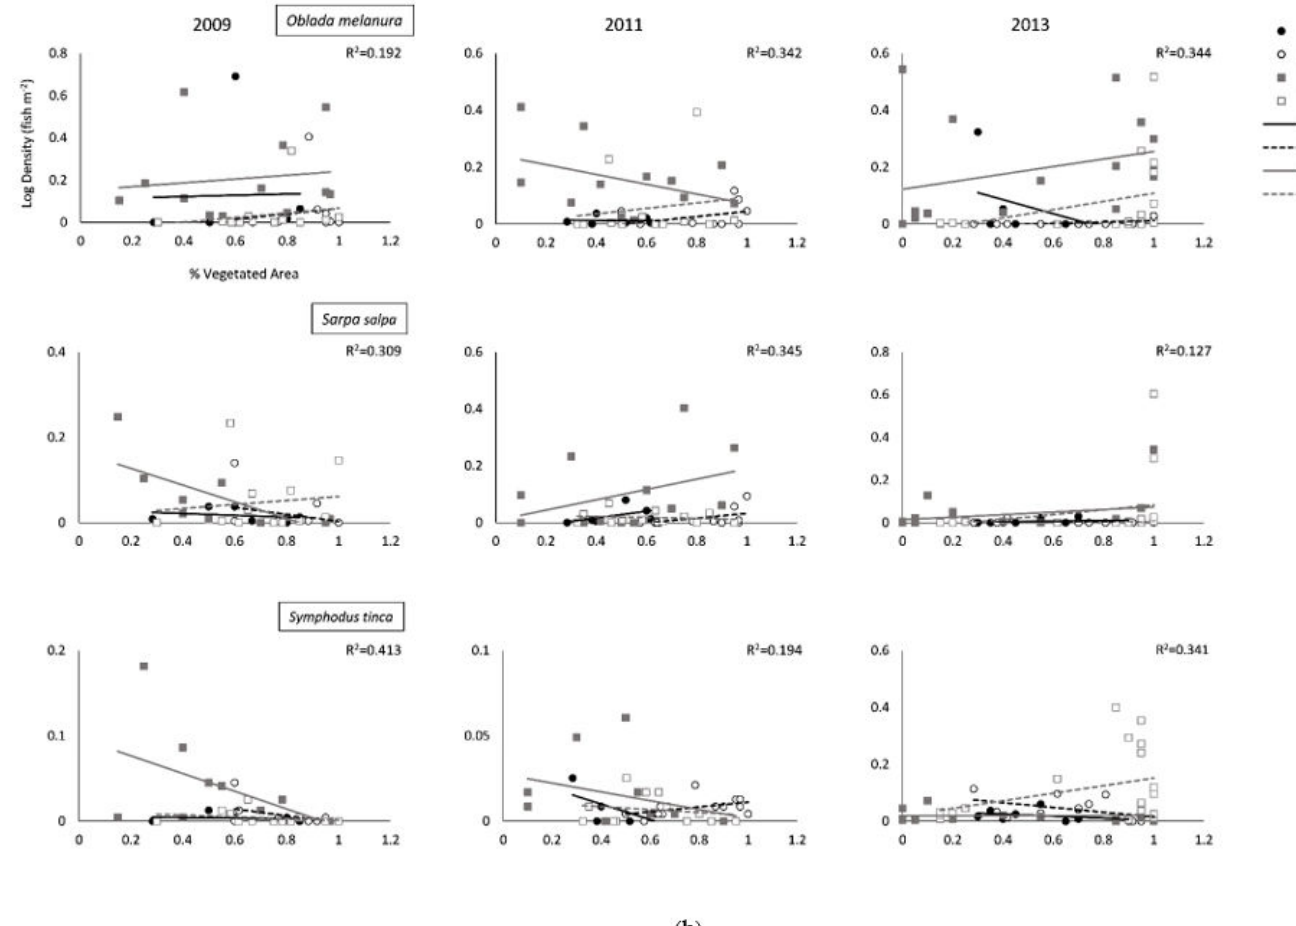
Figure 2. ( a ) Relationships (Global R 2 ) between the percentage of vegetated area surveyed and annual average density for all fishes and the five most abundant species per survey site ( Cabo de las Huertas —CH; Santa Pola —SP; Tabarca II—T2; Tabarca III—T3). Global R 2 values depict overall global fit for each ANCOVA model. ( b ). Relationships (Global R 2 ) between the percentage of vegetated area surveyed and annual average density for all fishes and the five most abundant species per survey site ( Cabo de las Huertas —CH; Santa Pola —SP; Tabarca II—T2; Tabarca III—T3). Global R 2 values depict overall global fit for each ANCOVA